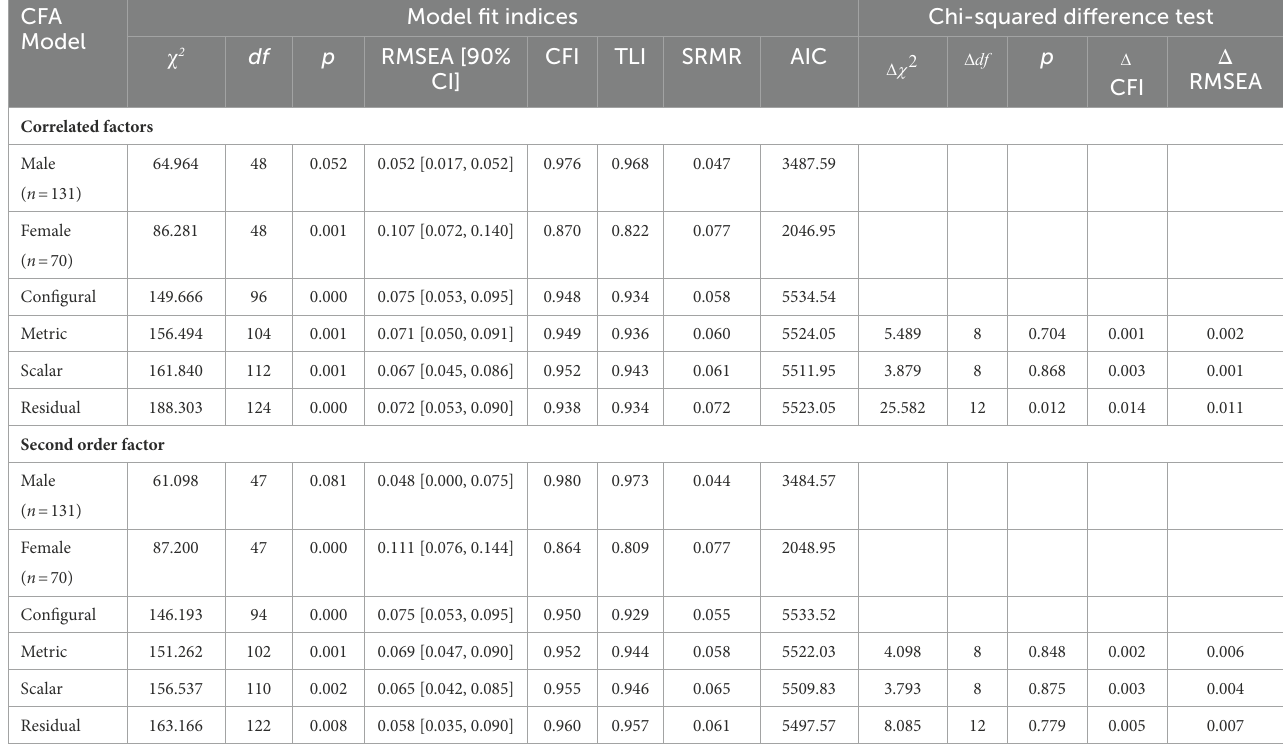
TABLE 4 Fit statistics of measurement invariance tests across gender based on (1) the correlated factors model and (2) the second-order factor